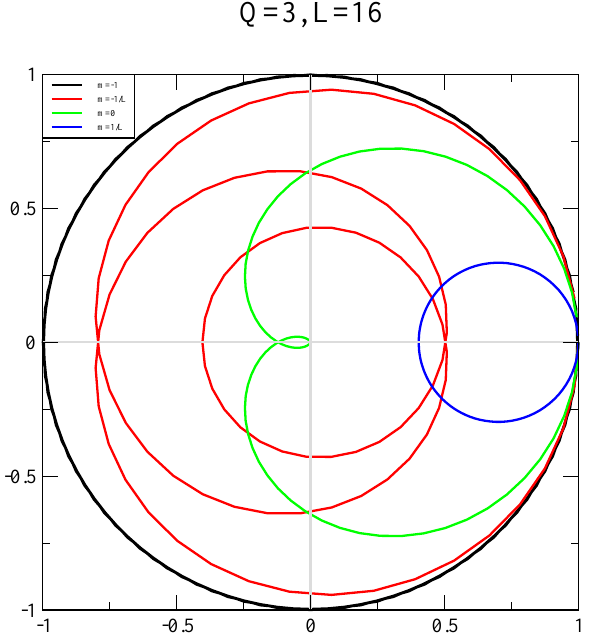
Figure 4. The flow of the overlap fermion determinant in the complex plane as a function of h 3 at a fixed Q = 3 on L = 16 lattice. The description is the same as in Figure 2.